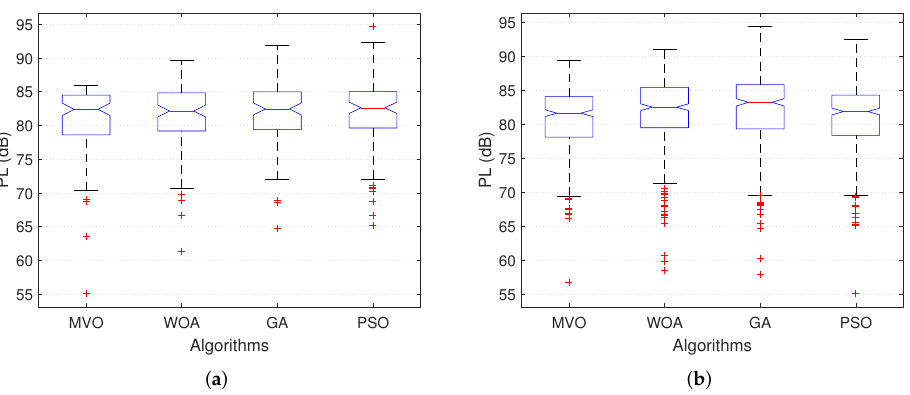
Figure 7. PL comparison of the algorithms MVO, WOA, GA and PSO. ( a ) INS-1 with 40 mesh routers. ( b ) INS-2 with 40 mesh